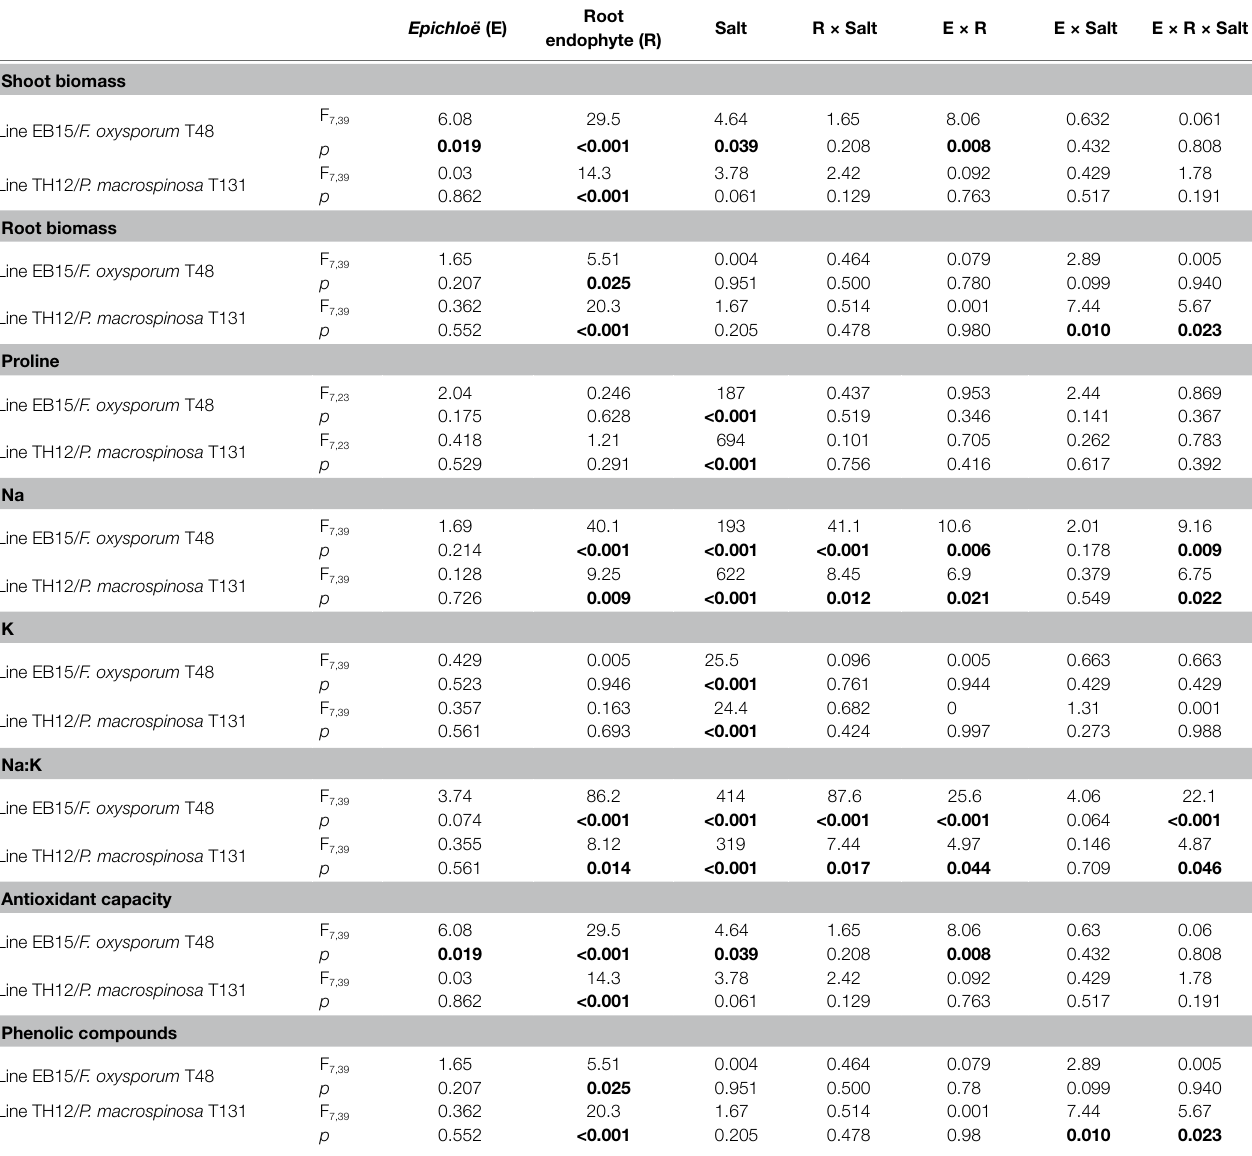
TABLE 1 | ANOVA results showing the effect of Epichloë presence, inoculation, and salt treatment on different parameters of F. rubra subsp. pruinosa plants. Epichloë